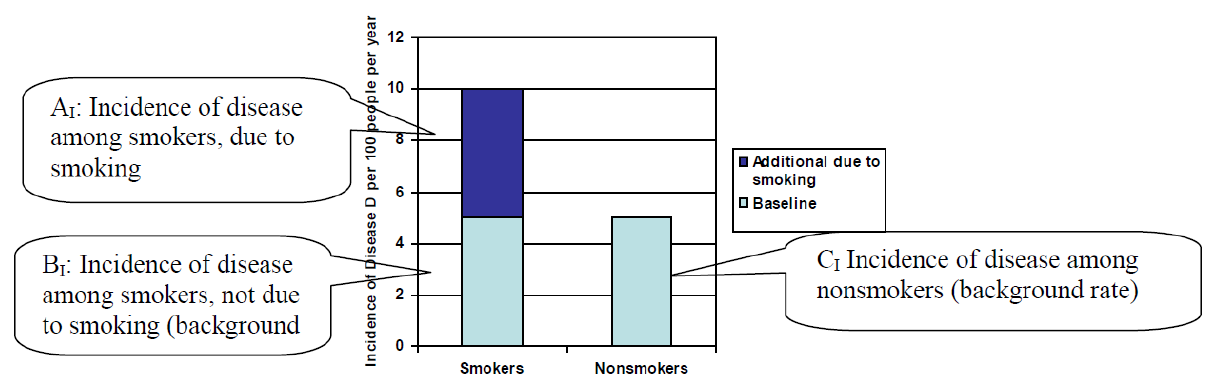
Figure 1. Incidence of disease among smokers and